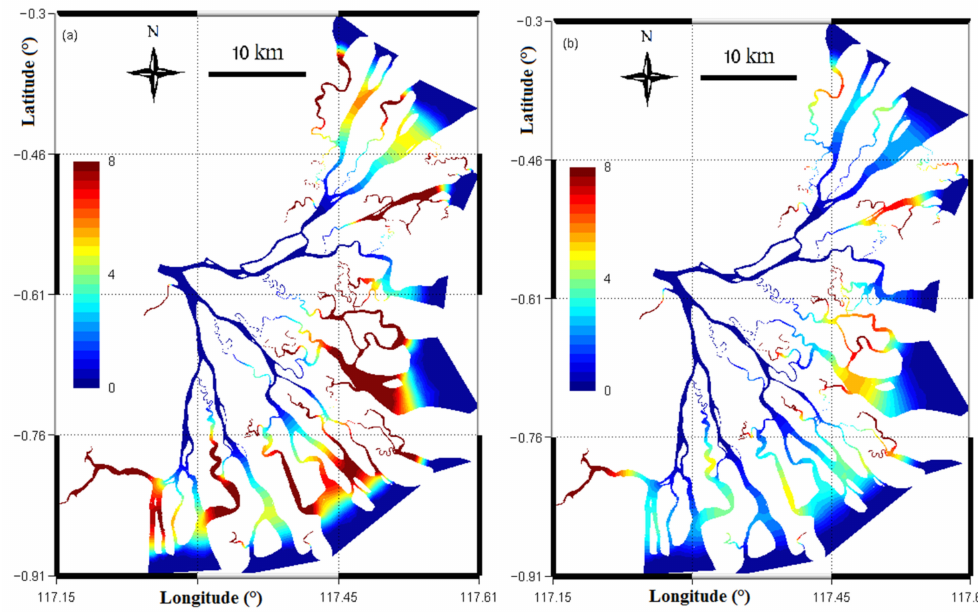
Figure 7. Distribution of the age of the total renewing water for the: ( a ) low and ( b ) high flow period. The color bar is cropped at 8 days in order to focus on the variation of the age in deltaic channels, and the unit is